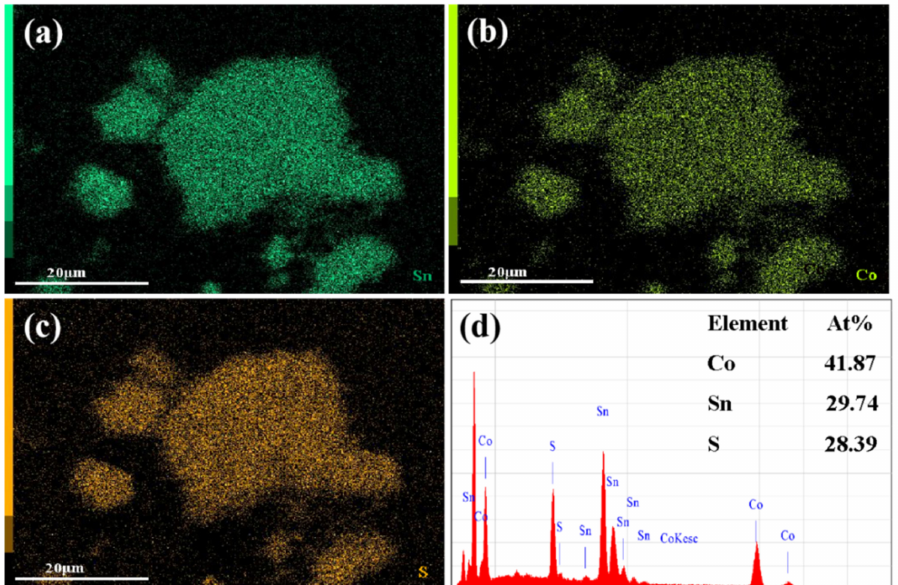
Figure 4. ( a ) Distribution of Co elements; ( b ) distribution of Sn element; ( c ) distribution map of S element; ( d ) EDS of Co 3 Sn 2 S 2 nanocrystals.